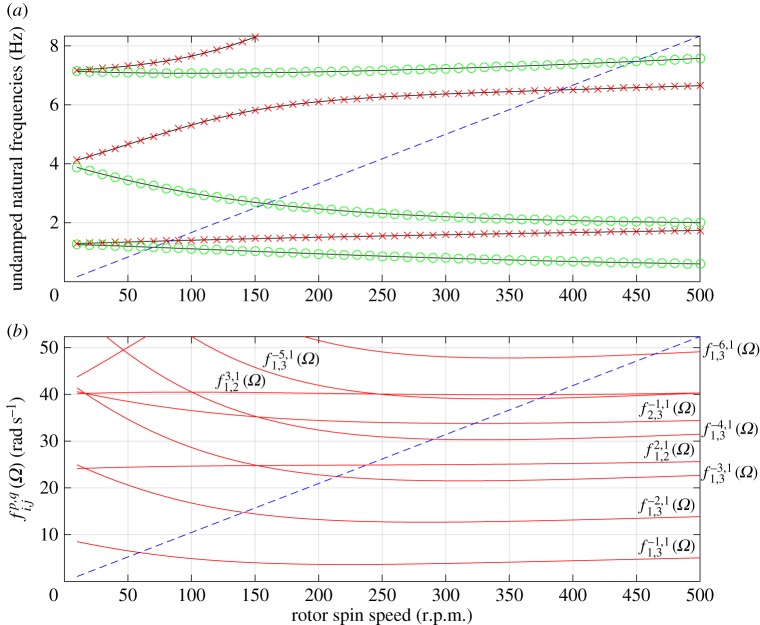
(a) Campbell diagram for test system, showing whirl frequencies in the stationary coordinate system. Crosses indicate forward whirls, circles indicate backward whirls. Dashed line indicates the shaft speed. (b) Evaluations of fi.jp,q(Ω) as given by equation (3.2). Labels indicate the choice of parameters used for the adjacent curve. Dashed line indicates the shaft speed. (Online version in colour.)